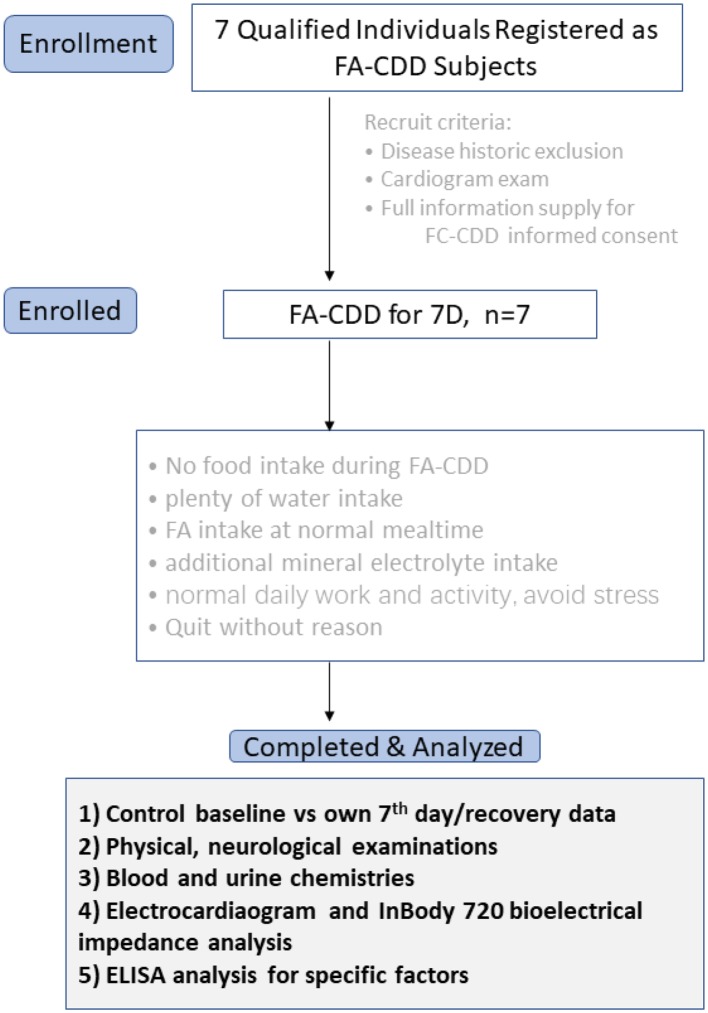
Flow chart of the clinical observation procedure.